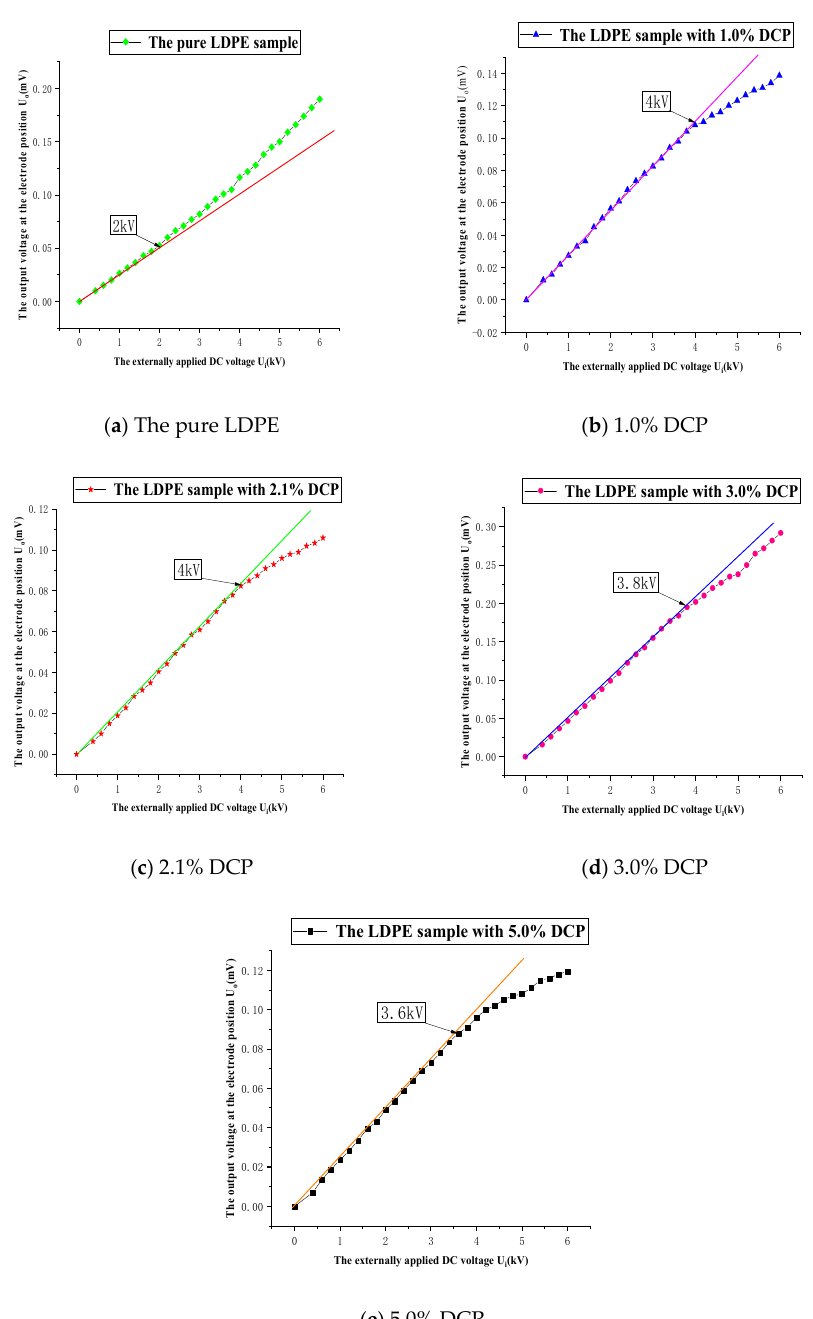
Figure 2. The experimental results of the stepwise voltage enhancement of the samples prepared by different contents of cross-linking agents. ( a ) The experimental result of the pure sample. ( b ) The experimental result of the sample with 1.0% dicumyl peroxide(DCP). ( c ) The experimental result of the sample with 2.1% DCP. ( d ) The experimental result of the sample with 3.0% DCP. ( e ) The experimental result of the sample with 5.0% DCP.